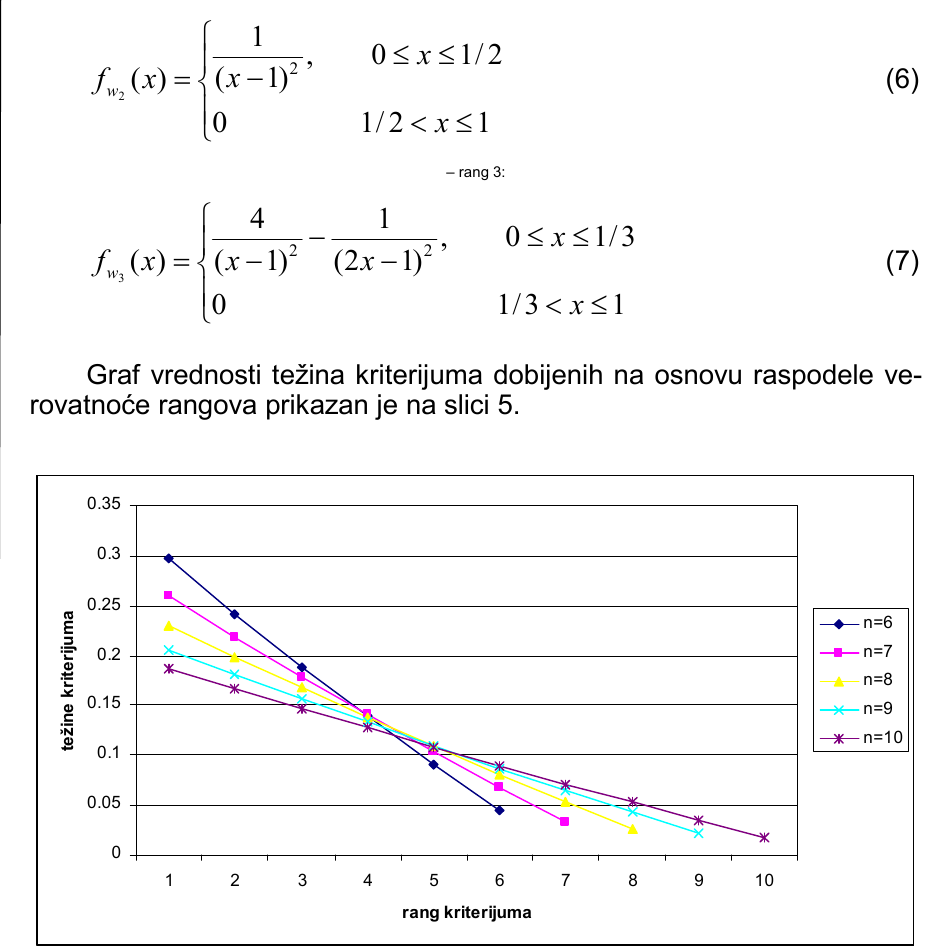
prikazan je na slici